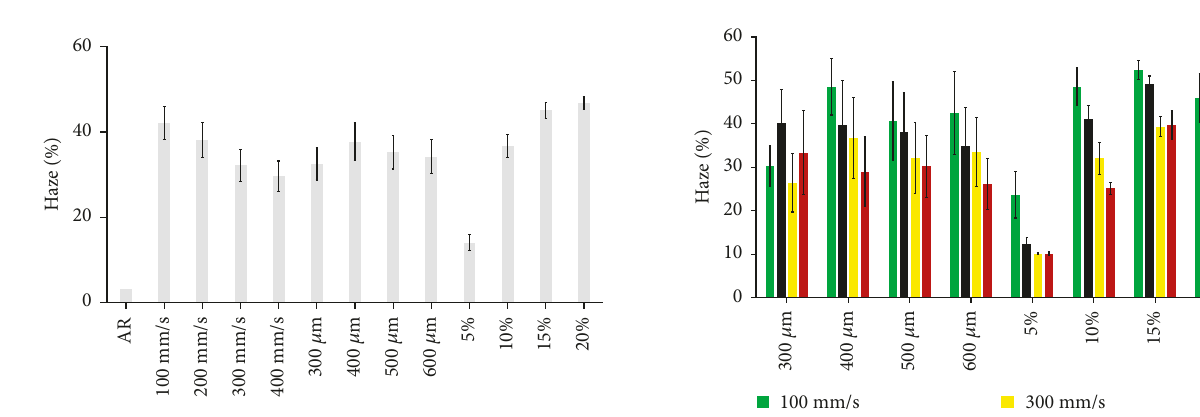
Figure 5: The averaged haze from 400 to 750 nm for each of the laser parameters tested and the unprocessed AR sample. The error bars show the standard error of the mean.